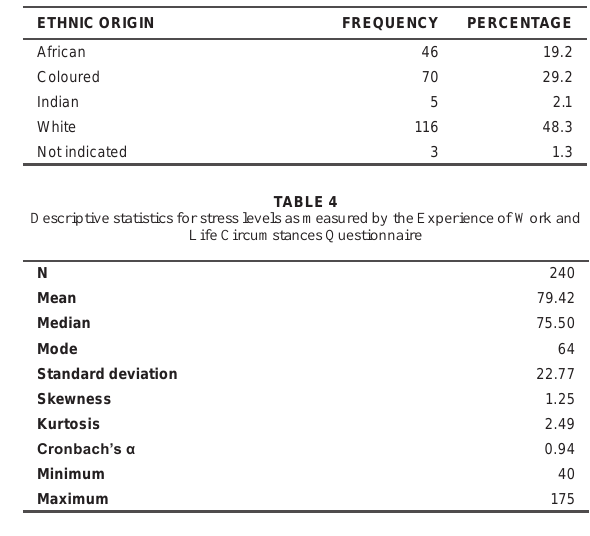
TABLE 3 Racial composition of the sample of employees